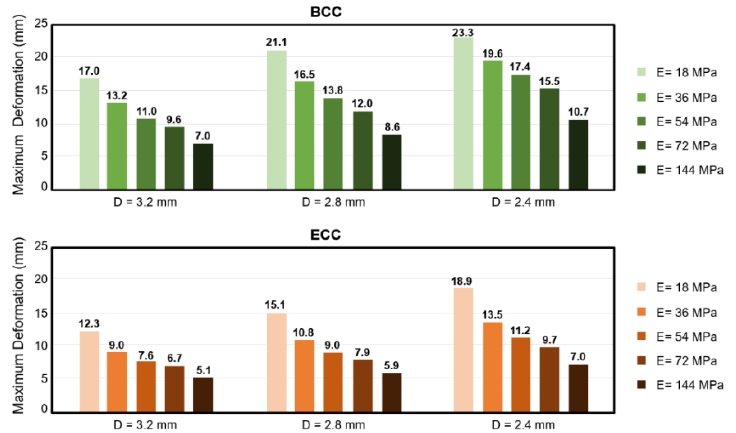
Figure 11. The comparison of the maximum deformation of sandwich structures with different material properties.